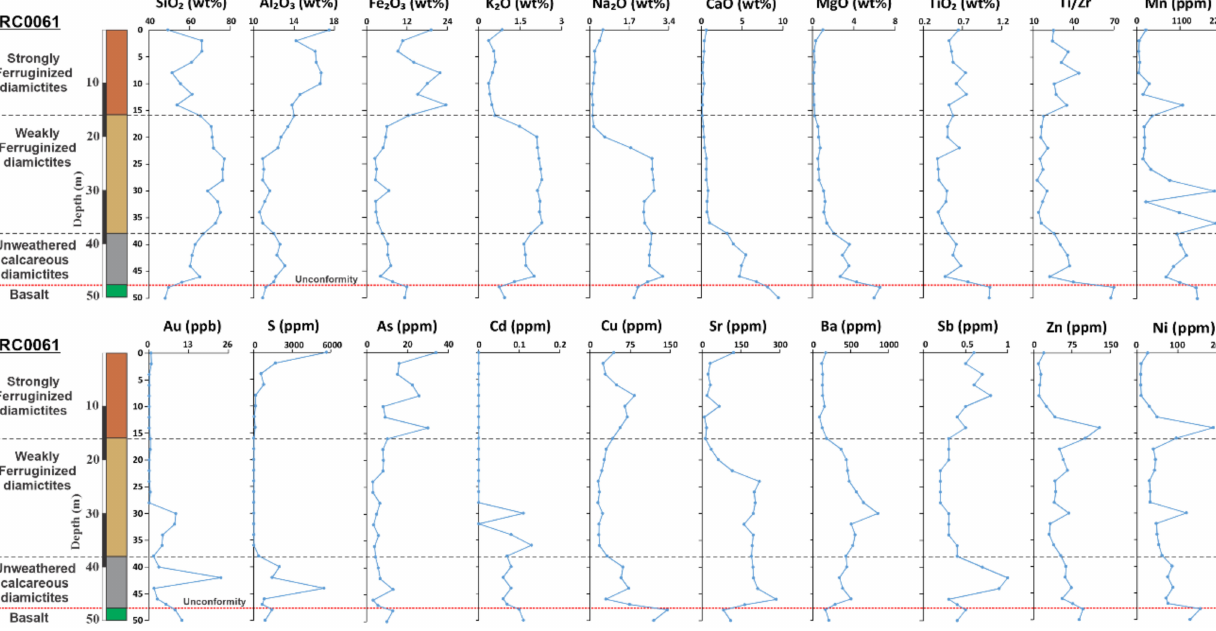
Figure 15. Vertical chemical variations in major oxides and trace elements in the bedrock and the Permian cover logged from drill hole